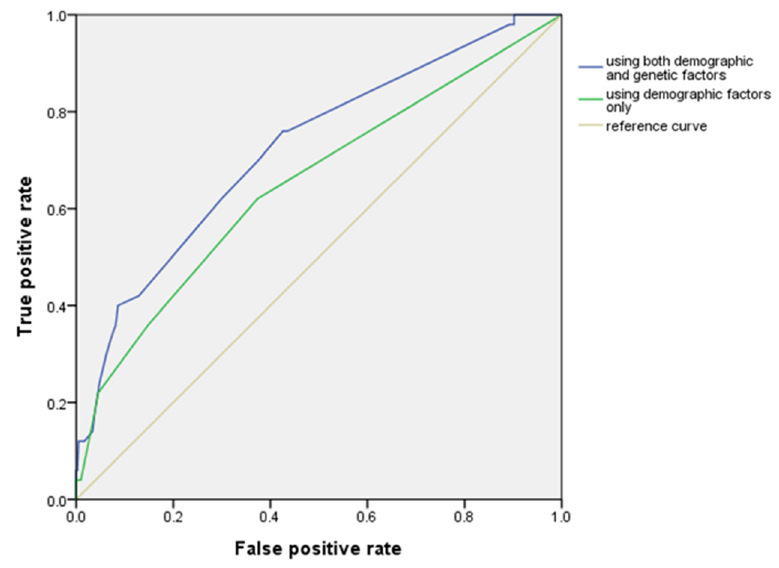
Figure 2. The receiver operating characteristic (ROC) curve for bleeding using demographic factors only and using both demographic factors and genetic factors.